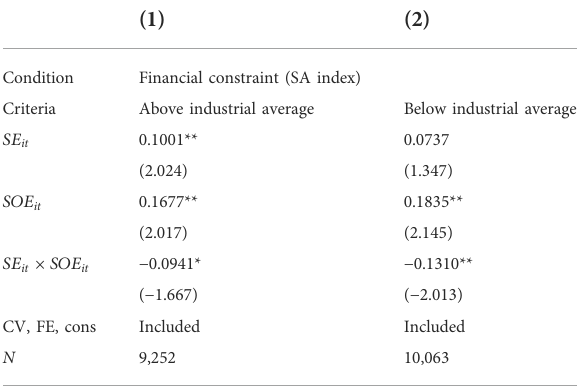
TABLE 5 Results of considering fi nancial constraint.